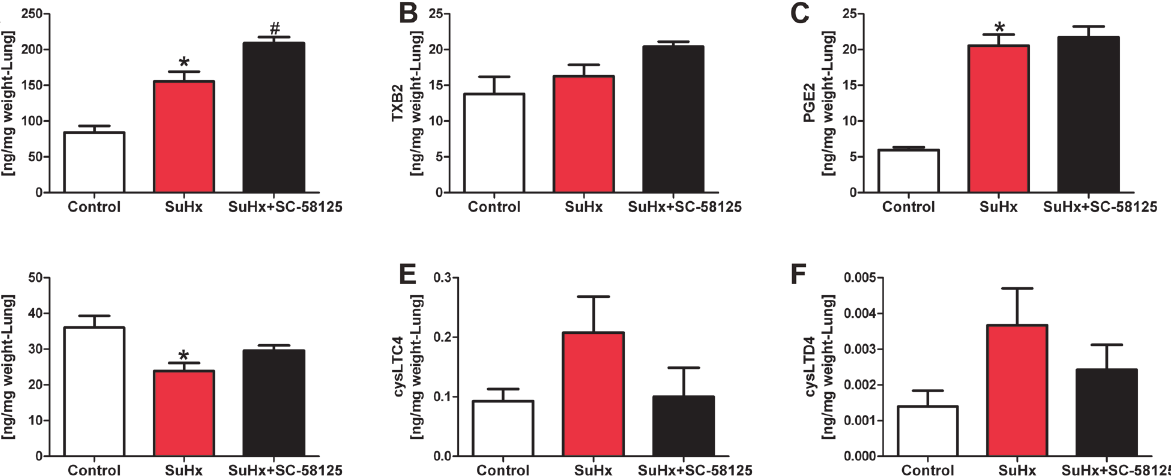
Fig 2. Eicosanoid metabolite concentrations (expressed in ng/mg lung tissue weight) in the lungs. There is an increase in 6-ketoPGF1 α (The stable metabolite of prostacyclin), and of PGE2 in the SuHx lung tissues. There was a trend for an increase of the LTC4 and LTD4 levels. Chronic treatment of SuHx rats with the COX-2 inhibitor SC-58125 did not prevent the increase in lung tissue concentration of 6-ketoPGF1 α or PGE2 (A, C). The COX-2inhibitor trended to affect the lung tissue increase of the LTC4 and LTD4 (E, F). * P < 0.05 vs. control, #P < 0.05 vs. SuHx. (n = 4).